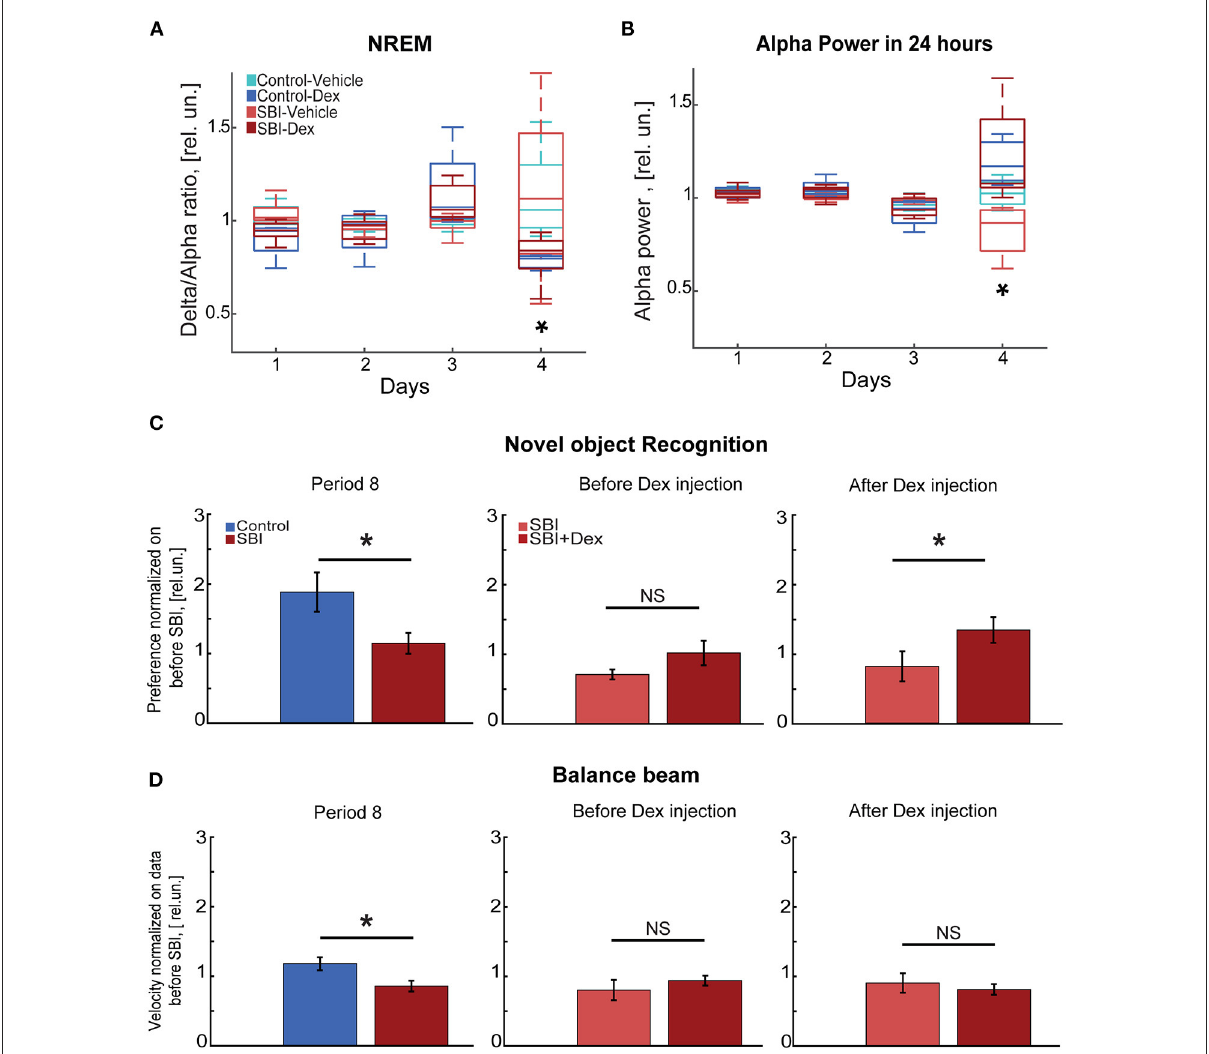
FIGURE6 Cognitive tasks improve a week after Dex injection. (A) Delta/alpha ratio differences between SBI-Dex ( n = 5), SBI-control ( n = 4), Control-vehicle ( n = 5), and Control-Dex ( n = 4) during the NREM detected over 24h and measured 3 days before SBI and compared to the ratio obtained a day after withdrawing Dex. Data were normalized to averaged ratio before SBI. (B) Alpha power measured 3 days before injury and compared to the alpha power measured a day after withdrawing Dex. Data were normalized to averaged alpha power before SBI. (C) Novel object task conducted at week 7 (period 8) in control ( n = 22) and SBI ( n = 28) mice, right side of the panel shows differences between SBI-vehicle ( n = 12) and SBI-Dex ( n = 16) groups observed before Dex injection (period 6) and 7 days post-Dex injection (period 8). Data